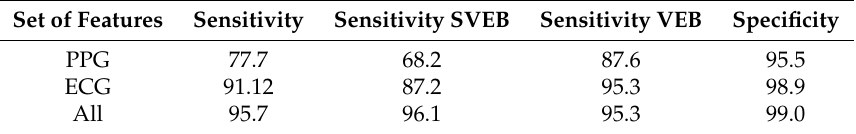
Table 6. The evaluation is conducted on the complete set of features and also on ECG and PPG features separately. The sensitivity is calculated for all ectopic beats and for both classes, respectively.